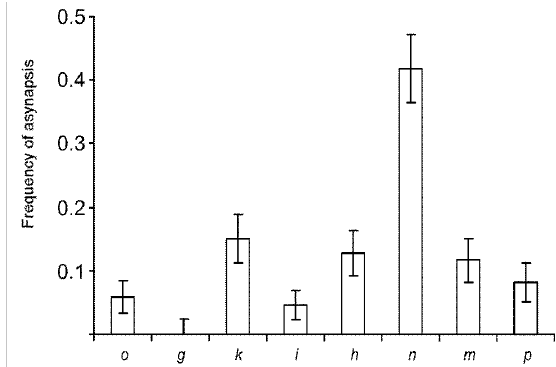
Figure 5. Frequency of asynapsis in the chromosome arms involved in the CIX configuration. Error bars show standard deviation. Letters indicate chromosome arms.